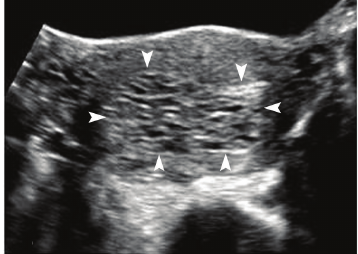
Figure 1: Complete hydatiform mole. Transverse transabdominal sonography (TAS) image of the uterus shows distension of the uterine cavity by echogenic material with numerous small, irreg- ular cystic spaces within (arrowheads). The normal hypoechoic myometrium can be seen stretched at the periphery. There is no identifiable fetal tissue.